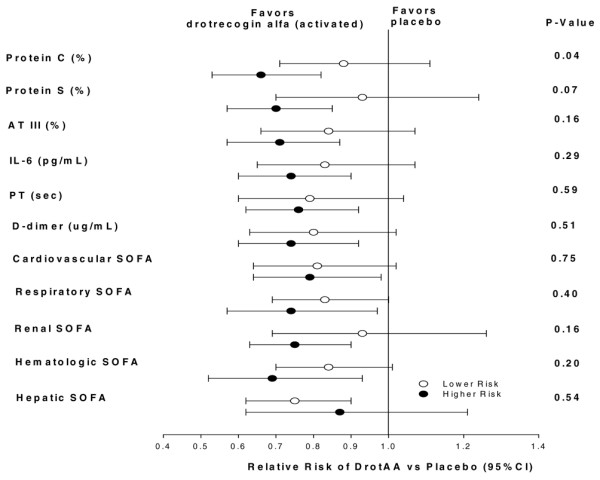
Illustration of 28-day mortality RR reduction (DrotAA versus placebo) for each potential biomarker at baseline. The point estimates of relative risk (RR) for death in patients at lower risk and higher risk, based on statistically defined cut-offs (shown in Table 2), are indicated by open ovals and solid ovals, respectively; 95% confidence intervals (CIs) are indicated by horizontal lines. Only protein C (PC) was significantly (P < 0.05) different between the two risk groups, as indicated by the least overlap in CIs, indicating a differential benefit. P values were determined using Breslow-Day tests. AT, antithrombin; CI, confidence interval; DrotAA, drotrecogin alfa (activated); IL, interleukin; PT, prothrombin time; SOFA, Sequential Organ Failure Assessment.